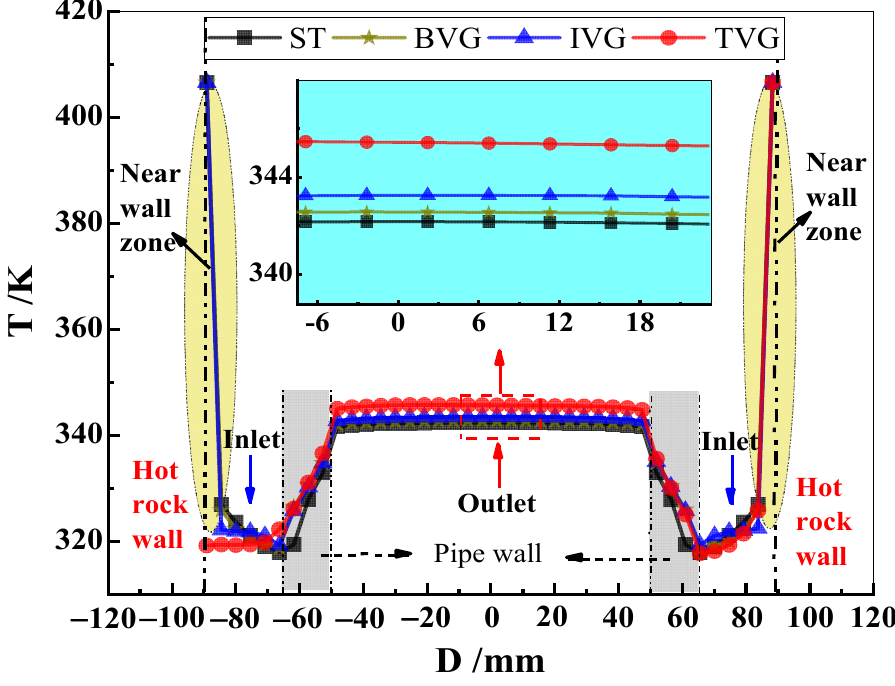
Figure 14. Radial temperature variation curve at the cross-section of the vortex generator region.